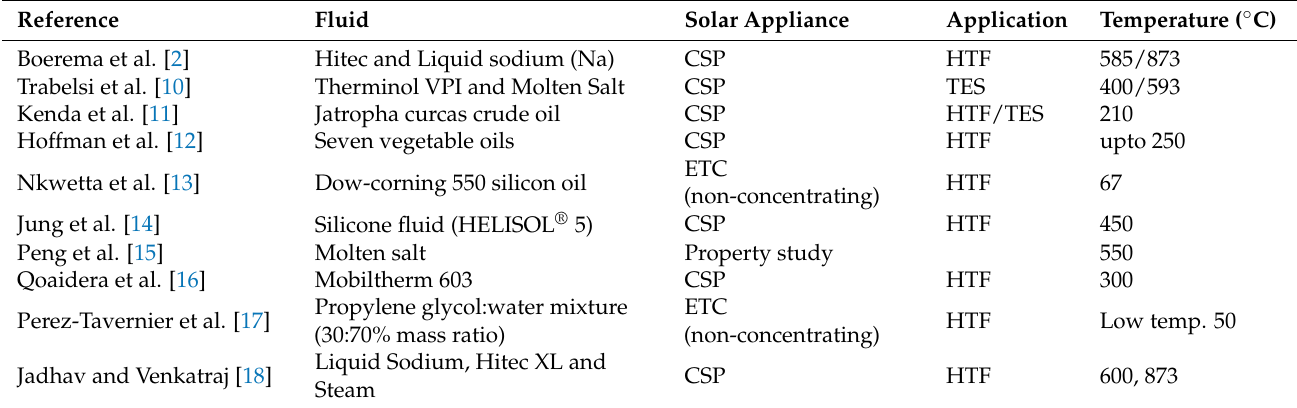
Table 1. Review on different HTFs and their solar